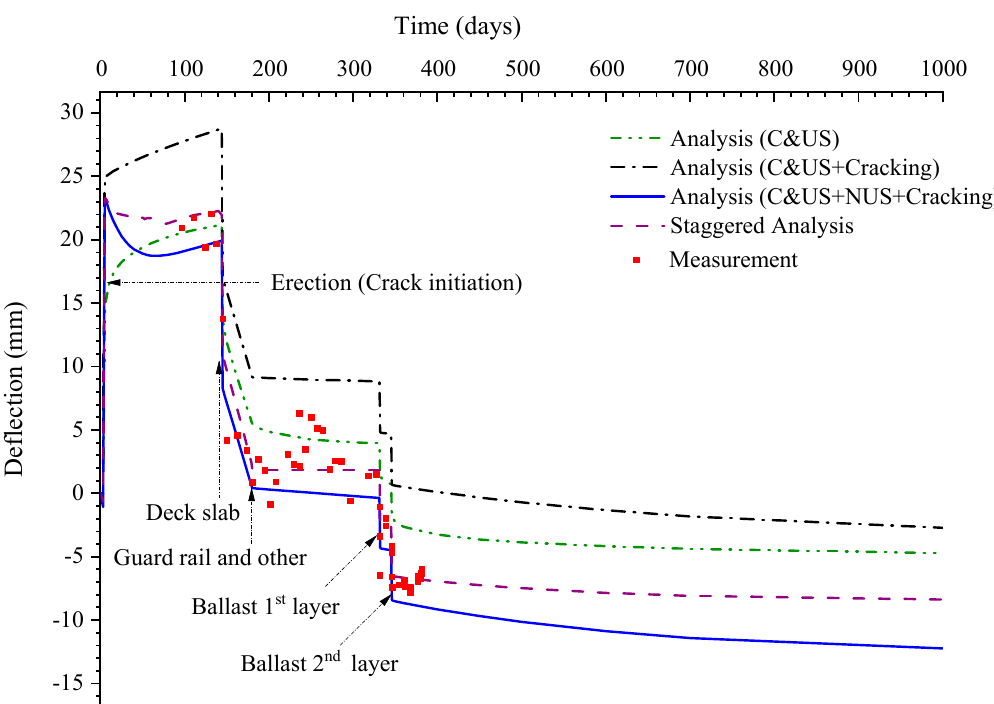
Figure 13. Variation of mid-span deflection with time in the medium-span PSC box girder.